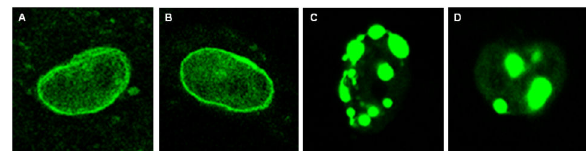
Figure 4. Expression of lamin A/C in cultured atrial cardiomyocytes. HL-1 atrial cardiomyocytes transfected with wild-type lamin A ( A ) and lamin C ( B ) in fluorescent expression vectors, showing the cell nucleus with homogenous nuclear veil. HL-1 atrial cardiomyocytes transfected with p.G232V mutant lamin A ( C ) and lamin C ( D ), showing the cell nucleus with aggregates.